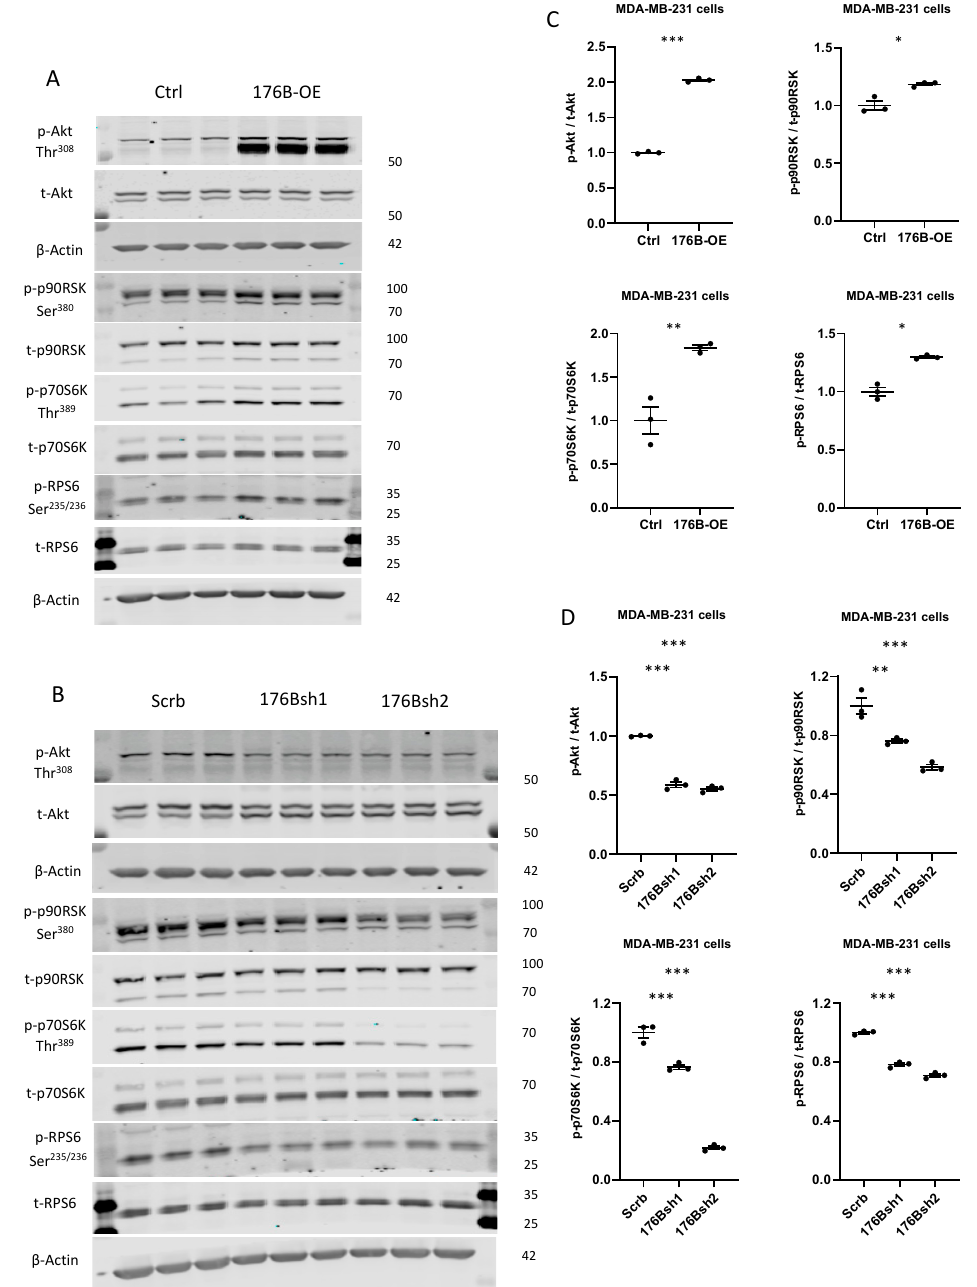
Figure 6. TMEM176B overexpression increased AKT/mTOR pathway activation, which was decreased in TMEM176B- silenced cells. ( A ) Representative Western blot of protein lysates from control (Ctrl) and TMEM176B-overexpressing (176B- OE) cells and ( B ) shRNA control (Scrb) and TMEM176B-silenced (176Bsh1, 176Bsh2) cells examining phospho-AKT (Thr 308 ) and total AKT, phospho-p90RSK (Ser 380 ), total- p90RSK, phospho-p70S6K (Thr 389 ), total-p70S6K, phospho-RPS6 (Ser 235/236 ), and total-RPS6 and β -Actin. ( C , D ) Densitometry analysis of Western blot was performed using the ImageJ software (n = 3 per group, with three independent experiments). Data are presented as means ± SEM. Differences between groups were evaluated by Student’s t -test ( C ) and the one-way ( D ) ANOVA test with the Bonferroni post hoc test. * p < 0.05, ** p < 0.01, *** p < 0.001. 70-kDa ribosomal protein S6 kinase (p70S6K) and ribosomal protein S6 (RPS6) ( A , C ). Conversely, in the TMEM176B-silenced cells, we found reductions in AKT (Thr 308 ) p90RSK, p70S6K, and RPS6 phosphorylation compared with control cells ( B , D ). These results suggest that the cation channel TMEM176B regulates the AKT/mTOR signaling pathway.